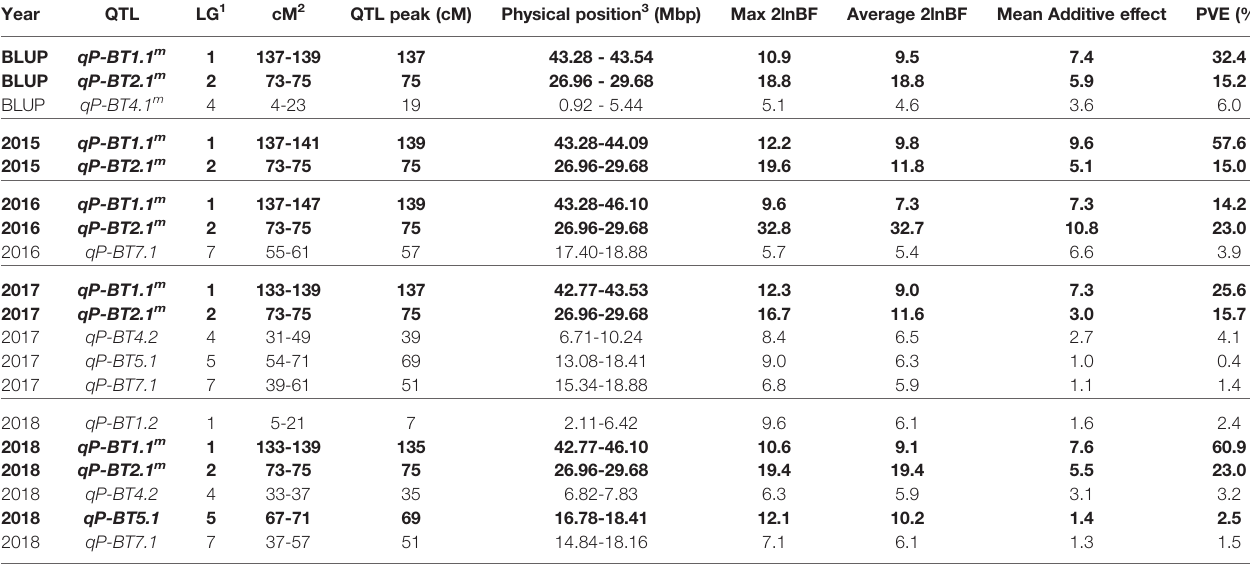
TABLE 1 | Bloom time quantitative trait loci (QTLs) identi fi ed with strong evidence (2lnBF > 5) in multiyear analysis [best linear unbiased prediction (BLUP) values] and single year analyses. Bold indicates decisive evidence for a QTL (2lnBF >